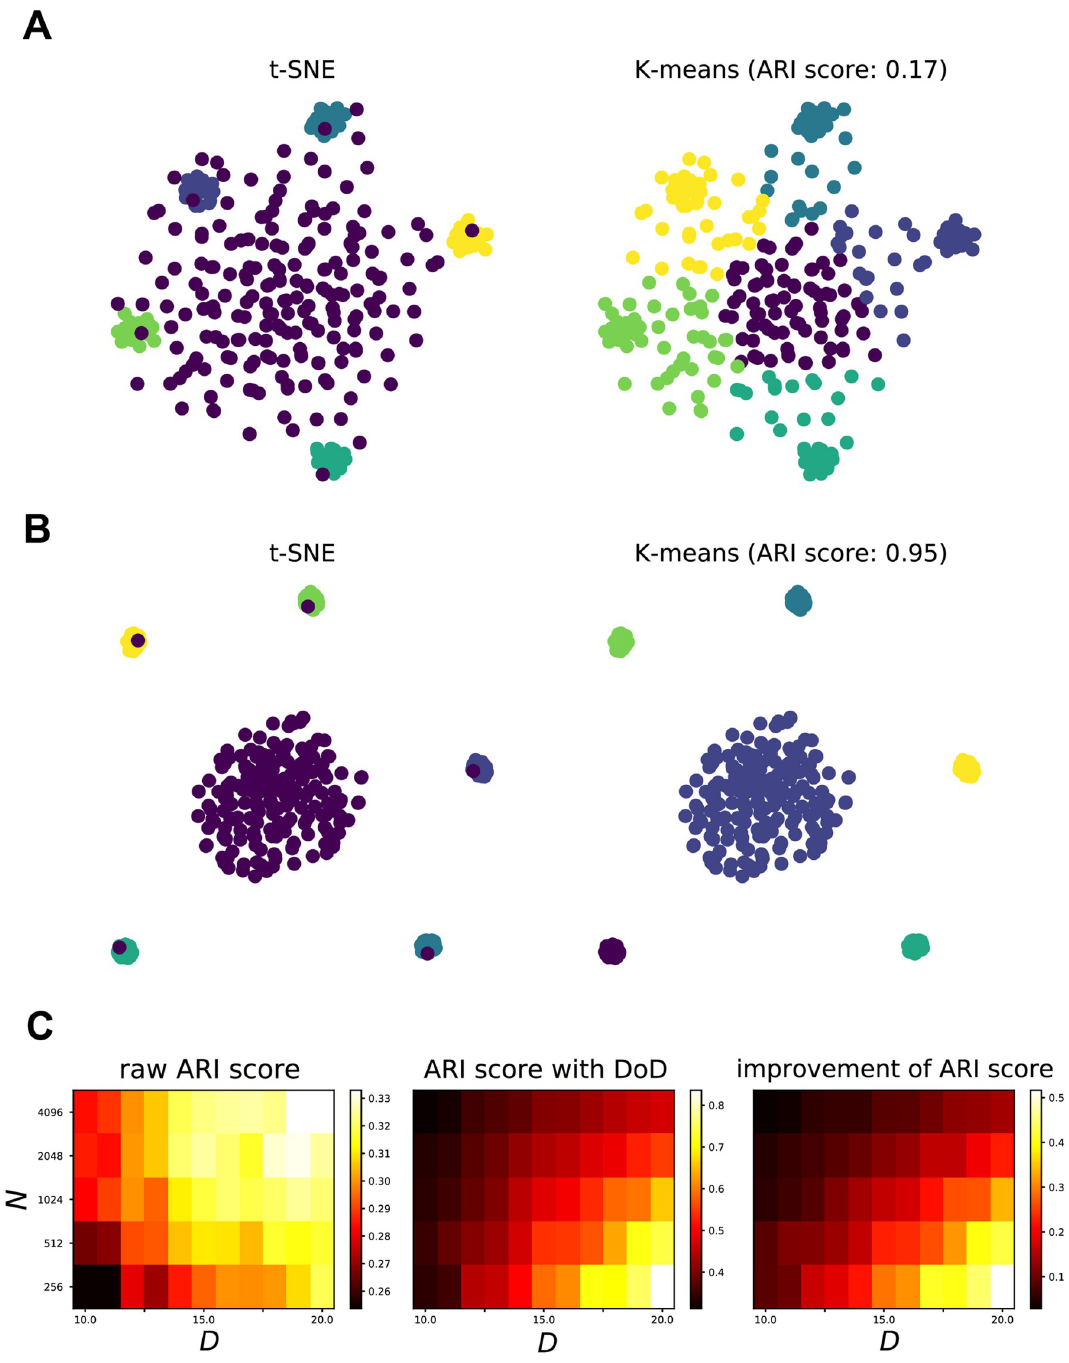
Fig 4. DoD transformation improves K-means clustering, with a linear dependence on dimensionality and a logarithmic dependence on the number of data points. A : Example of K-means clustering. We sampled 20 cluster points from five different multivariate Gaussian distributions with dimensionality D = 20. Another 500 noise points were sampled uniformly from the same space. Left , t-SNE visualization. Right , K-means clustering based on t-SNE embeddings. Colors correspond to the original labels. The ARI score of clustering was 0.17. B : Distance-of-distance transformation improves the clustering. Left , t-SNE visualization of the distance-of-distance matrix. Right , K-means clustering. The ARI score of clustering was 0.95. C : Effect of distance-of-distance on ARI score, as a function of the number of data points and the dimensionality. Data points were sampled accordingly with different number of noise points and dimensionality D . Dimensionality D varied from 10 to 20 linearly. The number of noise points N varied from 256 to 4096 exponentially with a base of 2. Left , The ARI score of K-means clustering on the t-SNE embeddings of the original distance